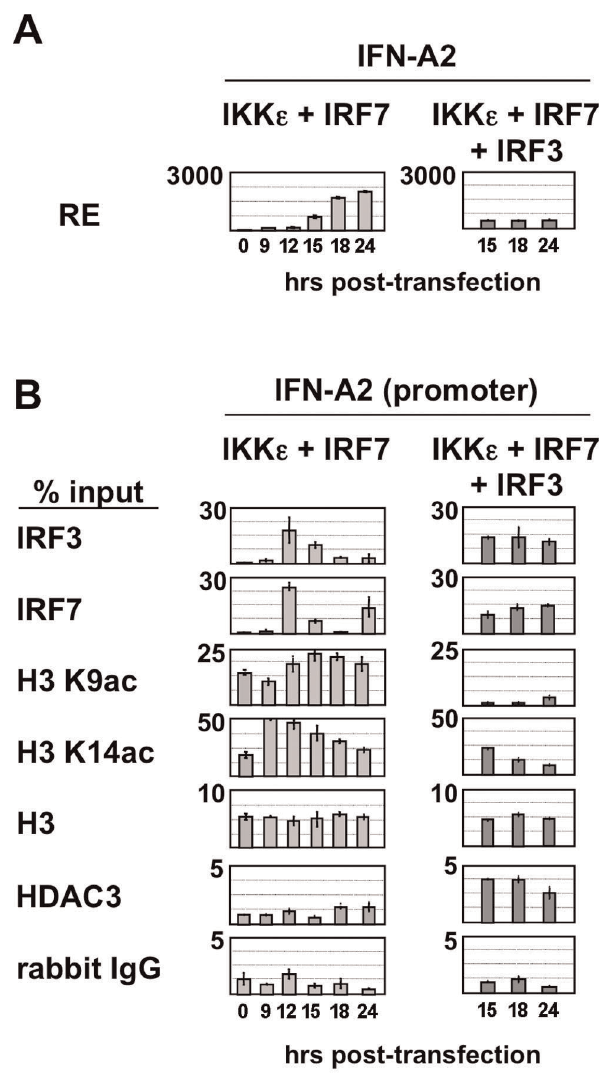
Figure 5. Regulation of histone H3 acetylation associated with the IFN-A2 gene promoter. ( A ) IFN-A2 expression was determined in HEK293-TLR3 cells co-expressing IKK e and IRF7 alone or together with IRF3. Cells were collected for RT-QPCR analysis at the indicated times (in hours) after transfection. ( B ) Acetylated histone H3K9, acetylated H3K14 and histone H3, as well as recruitment of IRF3, IRF7 and HDAC3 associated with the IFN-A2 gene promoter were determined by quantitative ChIP assays as described in Materials and Methods. Anti- rabbit IgG was used to determine non-specific binding.